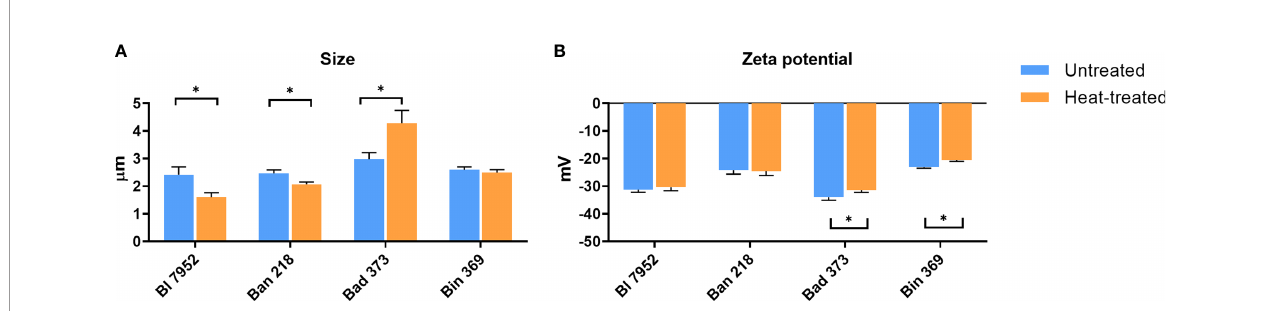
FIGURE 2 | Physicochemical differences between untreated and heat-treated bi fi dobacteria. (A) Size (µm) and (B) zeta potential measurements (mV) of untreated (UN, blue bars) and heat-treated (HT, orange bars) bi fi dobacteria strains were performed using Zetasizer Nano ZS. Data are shown as mean ± SD of fi ve measurements; statistical differences were analyzed by multiple t-tests between UN and HT, *p < 0.05 statistically signi fi